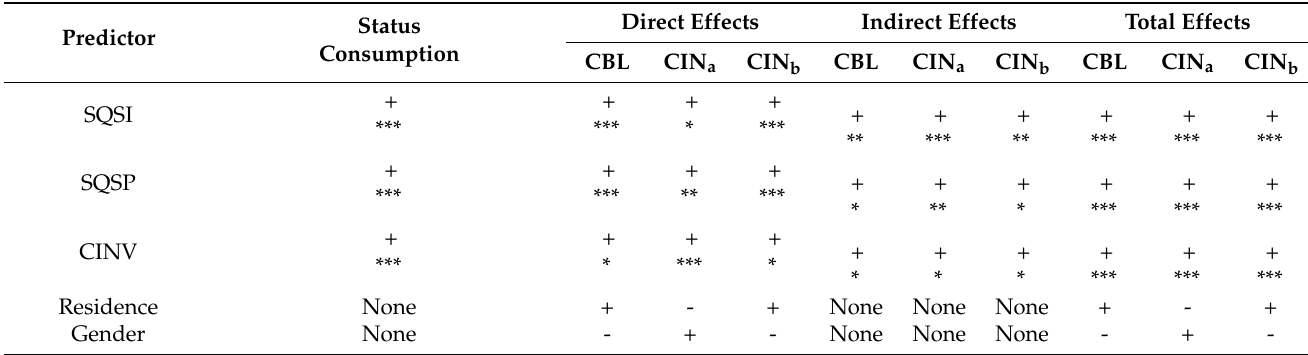
Table 12. Simplified structural equation model (with the